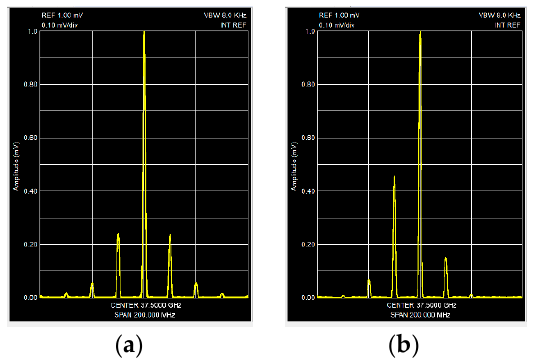
Figure 11. Spectrums of microwave oscillations of the output of the stabilized ( a ) and usual ( b ) (non-stabilized) oscillators.